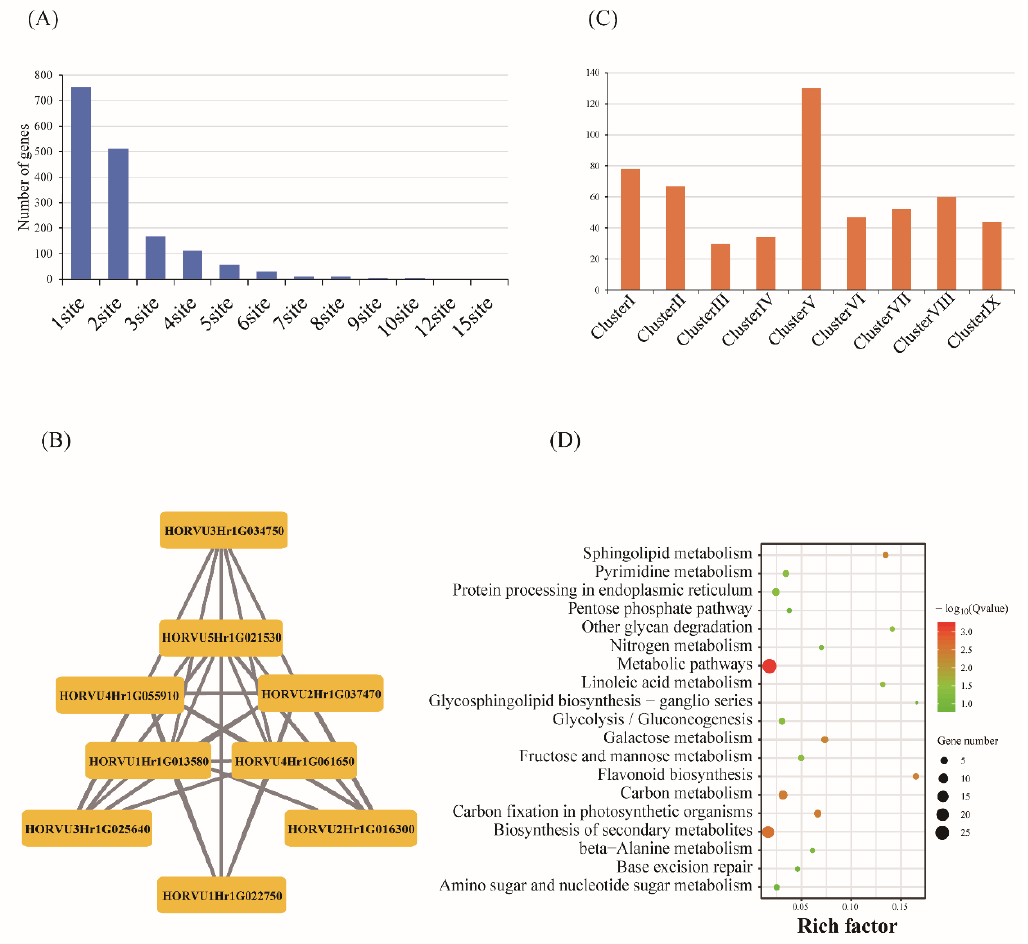
Figure 5. Frequency and functional enrichment of RNA-edited differentially expressed genes (DEGs). ( A ) The abundance of genes harbored the edit sites ranging from 1 to 15. ( B ) The regulatory network of the identified DEGs with RNA editing sites involved in embryonic defects. ( C ) Frequency of RNA-edited DEGs in nine expression clusters. ( D ) KEGG enrichment analysis of the RNA-edited DEGs identified in this study.